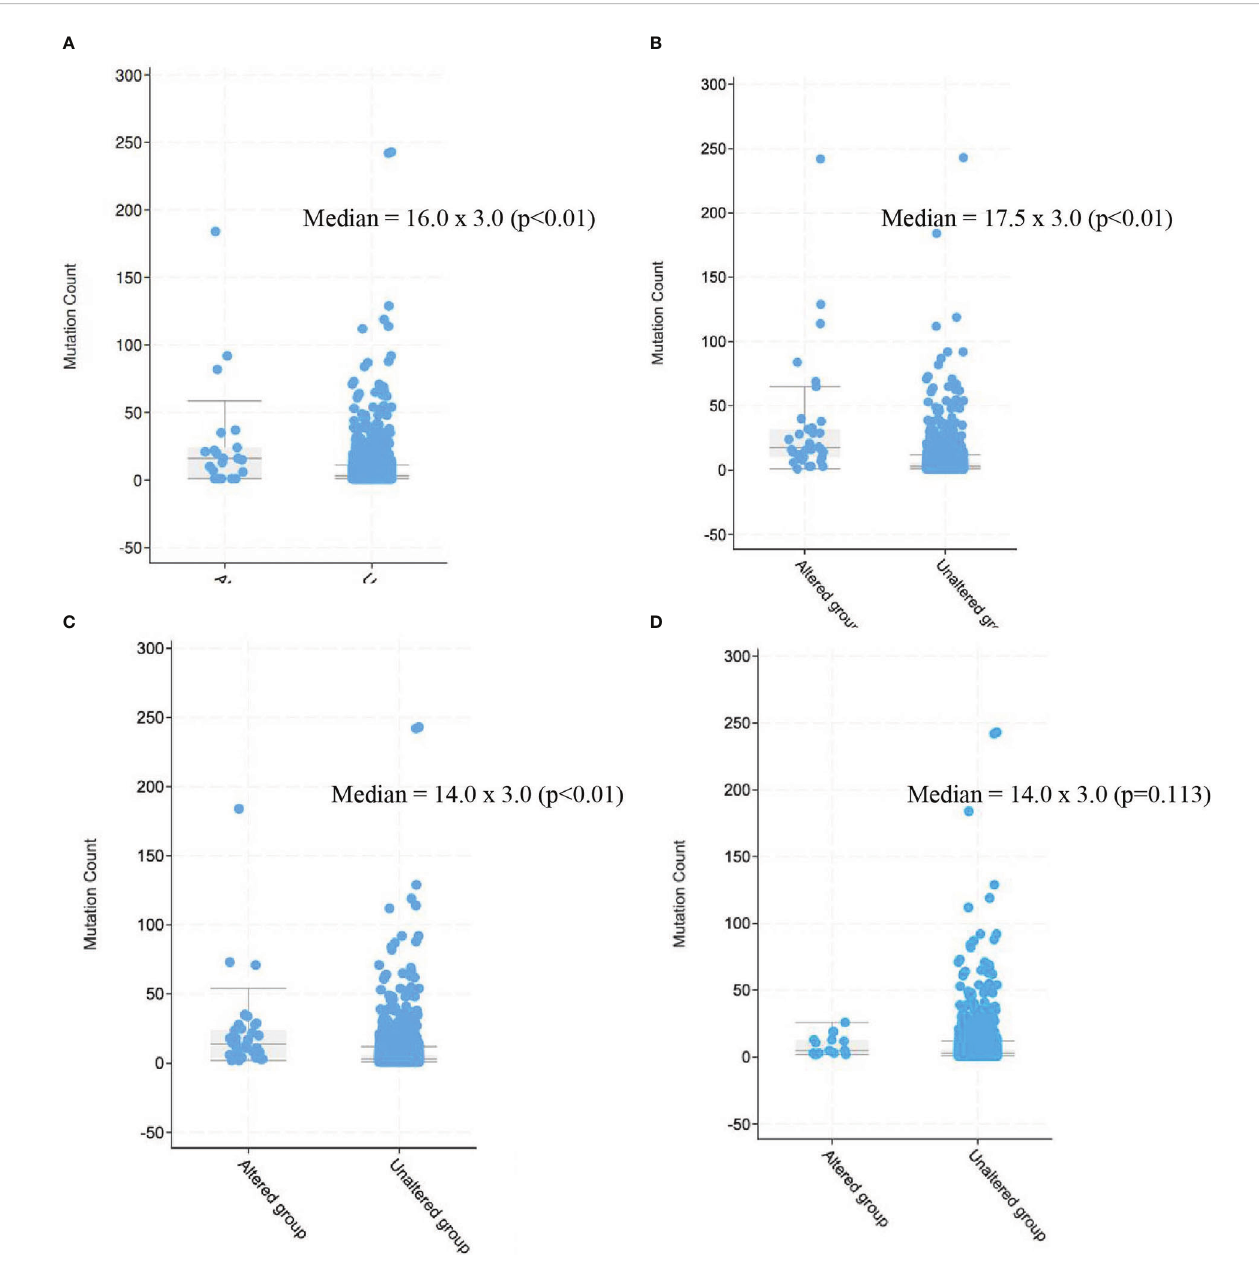
FIGURE 5 Mutation count in patients with sarcomas harboring alterations in mismatch repair genes as compared with those without alterations. (A) MLH1, (B) MSH2, (C) MSH6, (D) PMS2. 2.3 BRAF V600E mutation, BRAF V600E mutation was present in 17 patients overall (0.3%), including 11 patients